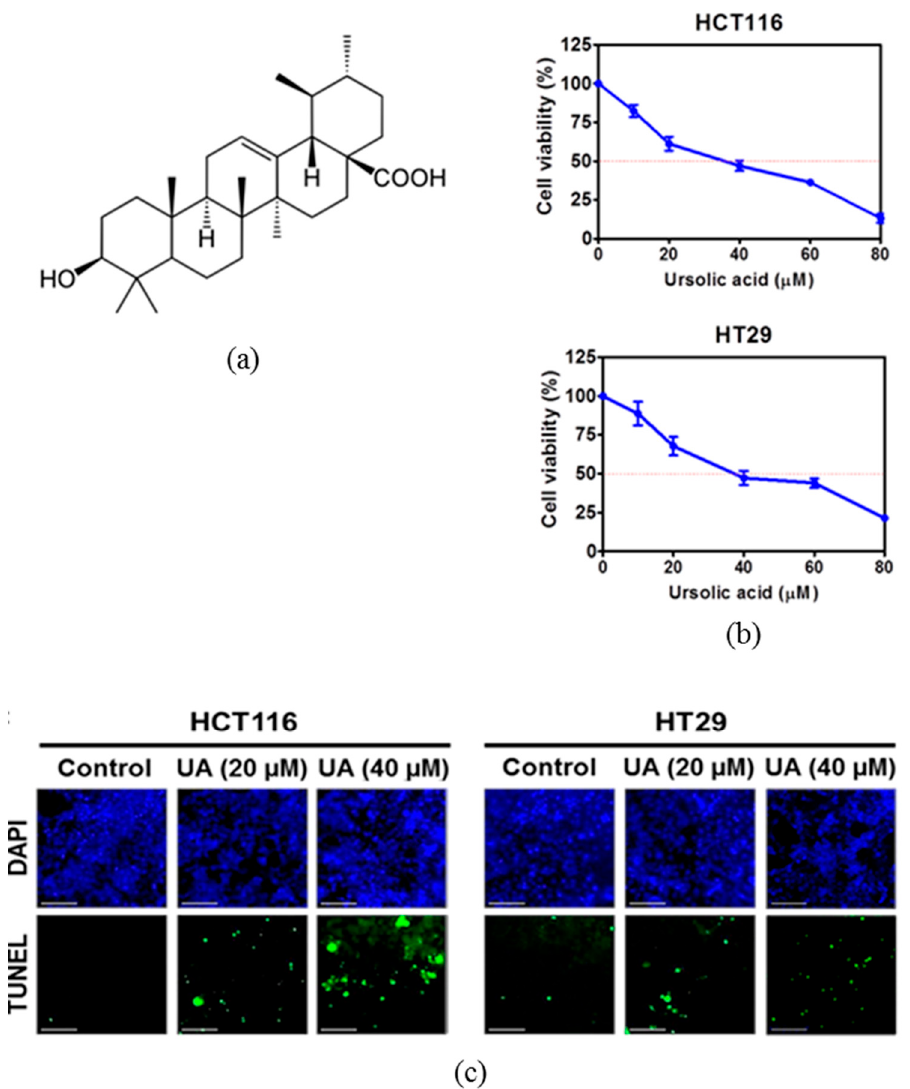
Figure 1. The effect of ursolic acid on cytotoxicity and terminal deoxynucleotidyl transferase-dT- mediated dUTP nick end labelling (TUNEL) positive cells in HCT116 and HT29 cells. ( a ) Chemical structure of ursolic acid. Molecular weight: 456.7 g/mol, molecular formula C30H48O3. ( b ) Cytotoxicity of ursolic acid was evaluated in HCT116 and HT29 cells. The cells were seeded into 96 well microplates and treated with various concentrations (0, 10, 20, 40, 60, or 80 μ M) of ursolic acid for 24 h and then subjected to an MTT assay. ( c ) Effect of ursolic acid on the number of TUNEL positive cells in HCT116 and HT29 cells. Cells were treated with ursolic acid (0, 20, and apoptotic TUNEL labeled cells (green), and DAPI stained cell nuclei (blue) by using a Delta Vision imaging system. Scale bar = 40 μ m.